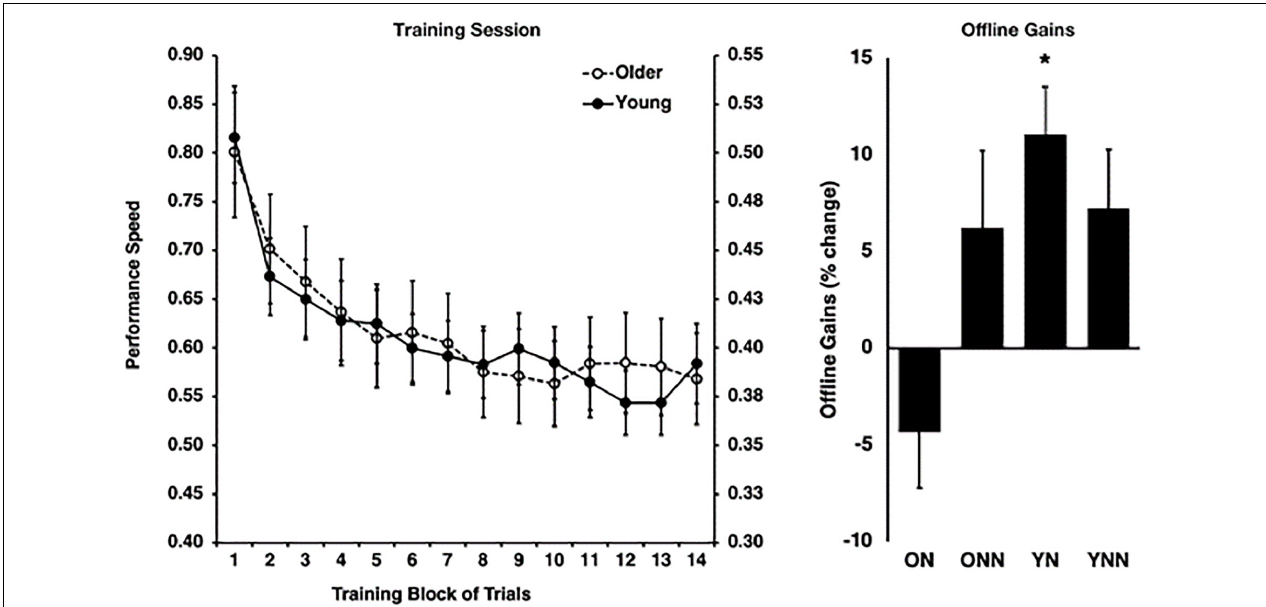
FIGURE 2 | Left panel : behavioral performance speed on the motor sequence learning (MSL) task at training for young (right y -axis) and older (left y -axis) groups. Right panel : offline gains in performance (% change last four blocks of training to first four blocks of retest). *Indicates statistically significant ( p < 0.05) offline gain in the Young Nap condition (YN). YN, Young Nap; YNN, Young No Nap; ON, Older Nap; ONN, Older No Nap.